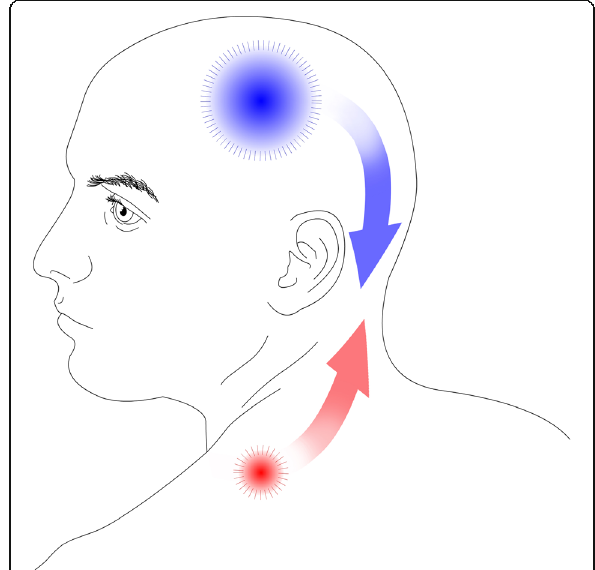
Fig. 1 The bottom-up model states that increased peripheral nociceptive transmission sensitizes the central nervous system to lower the threshold for perceiving pain while the top-down model suggests these changes are already present in central nervous system. In relation to myofascial trigger points, a bottom-up model would suggest that increased nociceptive transmission from myofascial trigger points lowers the threshold for perceiving pain (red). A top-down model would suggest that central sensitization may contribute to the occurrence of myofascial trigger points rather than the other way around